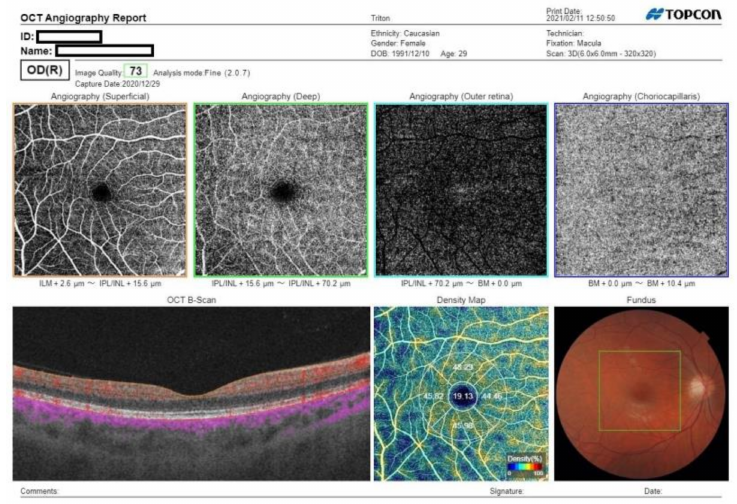
Figure 1. Optical coherence tomography angiograms of a patient, one month from COVID-19 onset. There are no remarkable abnormalities